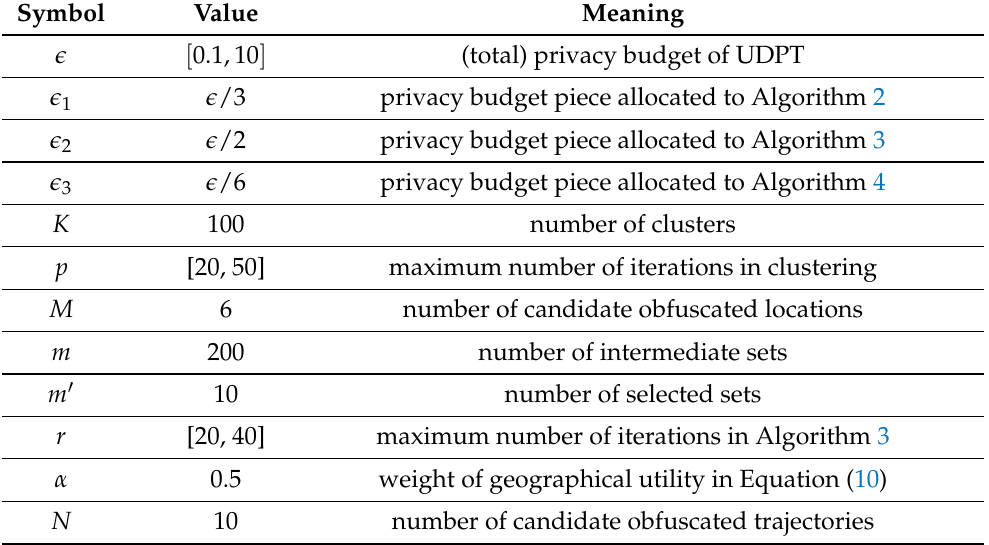
Table A2. Parameters in the